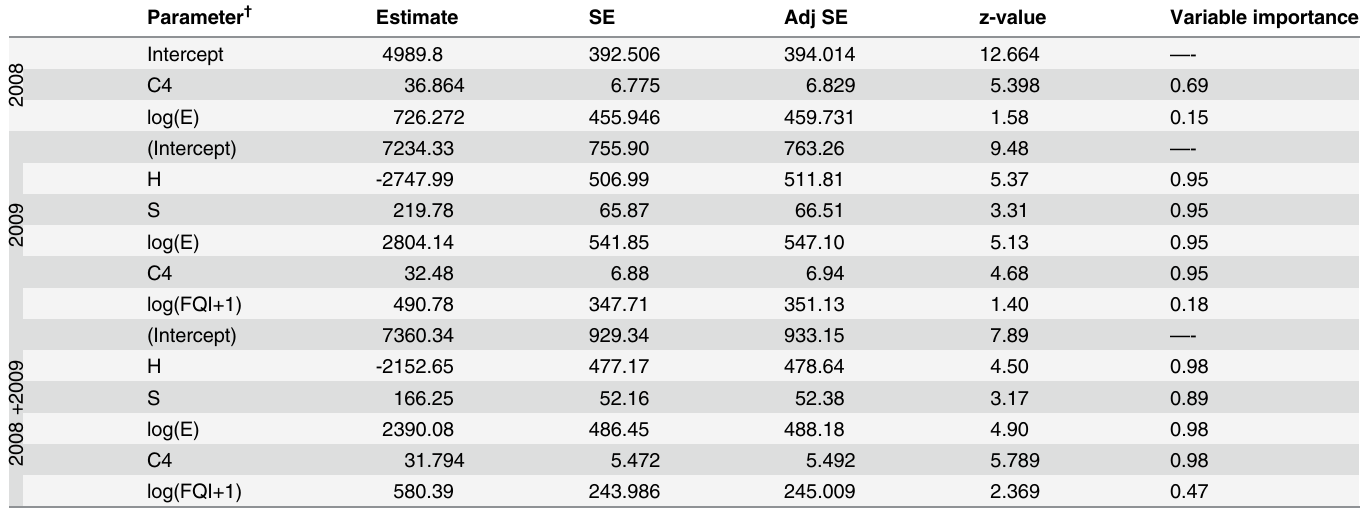
Table 4. Parameter estimates, adjusted standard errors (SE), and z-values for model averaging analysis within each time period. Parameter † Estimate SE Adj SE z-value Variable importance